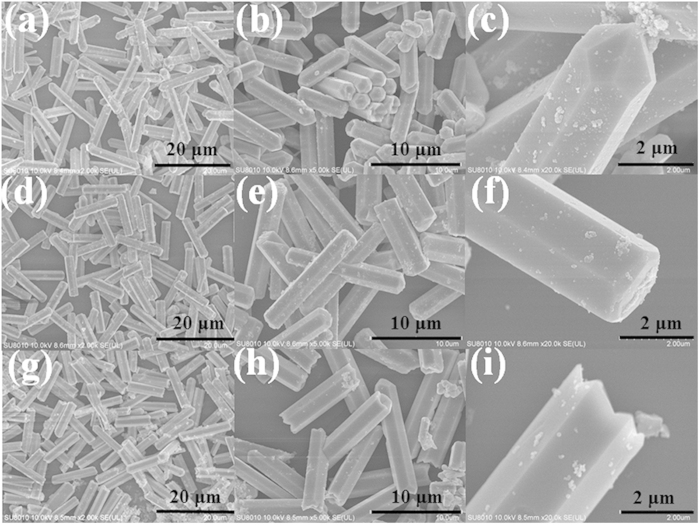
FE-SEM images of β-NaYF4 samples prepared with different molar ratio of KF to Y3+.(a–c) KF/Y3+ = 16; (d–f) KF/Y3+ = 30; (g–i) KF/Y3+ = 50.